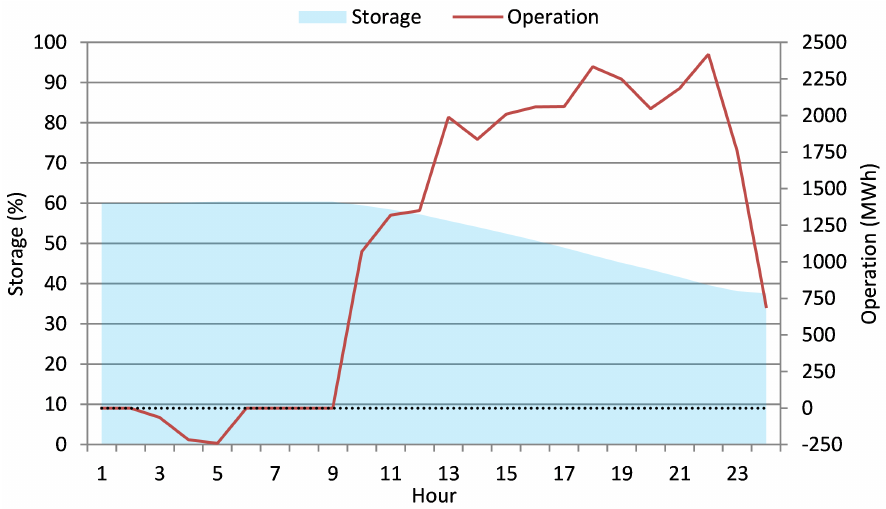
Figure 10. Strategic operation of the ”GenCo WindPower” agent and changes in the reservoir